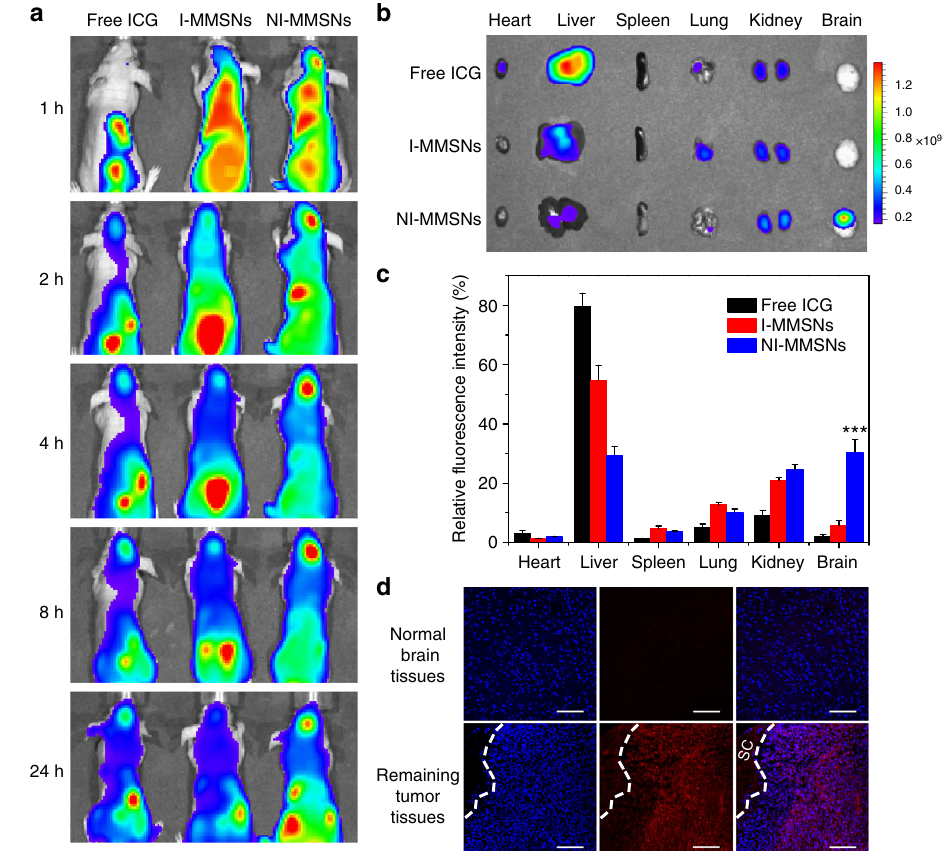
Fig. 5 In vivo biodistribution of neutrophils carrying MMSNs. a In vivo fl uorescence images of postsurgical glioma-bearing mice captured at the indicated time points after intravenous administration of free ICG, I-MMSNs, and NI-MMSNs. b Ex vivo fl uorescence images of major organs excised from mice intravenously injected with free ICG, I-MMSNs, and NI-MMSNs at 4 h of postinjection. c Quanti fi cation analysis of relative fl uorescence intensity in the organs at 4 h after intravenous injection. Mean values and error bars are de fi ned as mean and s.d., respectively ( n = 3). Statistical signi fi cance is assessed by Student ’ s two-sided t test compared to the control group. *** P < 0.001. d CLSM images of normal brain tissues and remaining tumor tissues in the postsurgical glioma-bearing mice after injection of NI-MMSNs. SC indicates the surgical cavity. Blue fl uorescence: nuclei, red fl uorescence: ICG. Scale